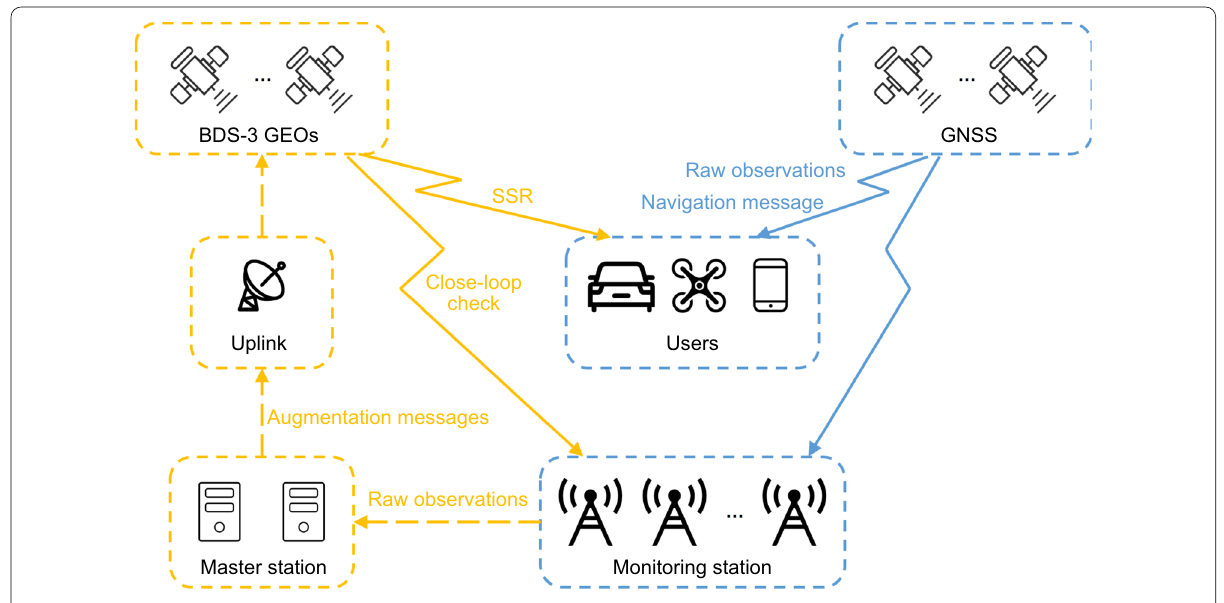
Fig. 3 BeiDou precise point positioning service